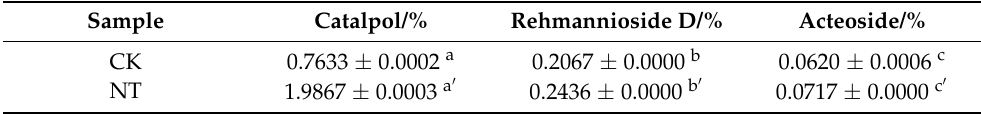
Table 2. Determination of quality marker contents by HPLC.